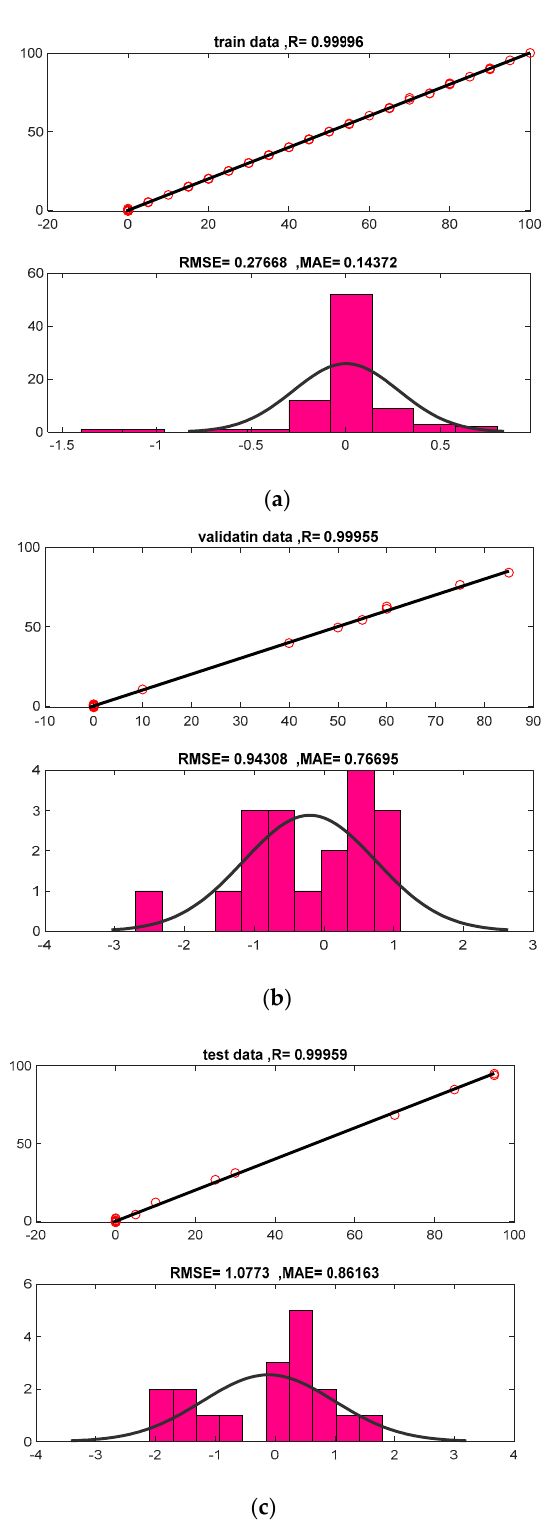
Figure 6. Operation of the designed neural network to recognize the volumetric ratio of ethylene glycol ( a ) train data, ( b ) validation data, and ( c ) test data.